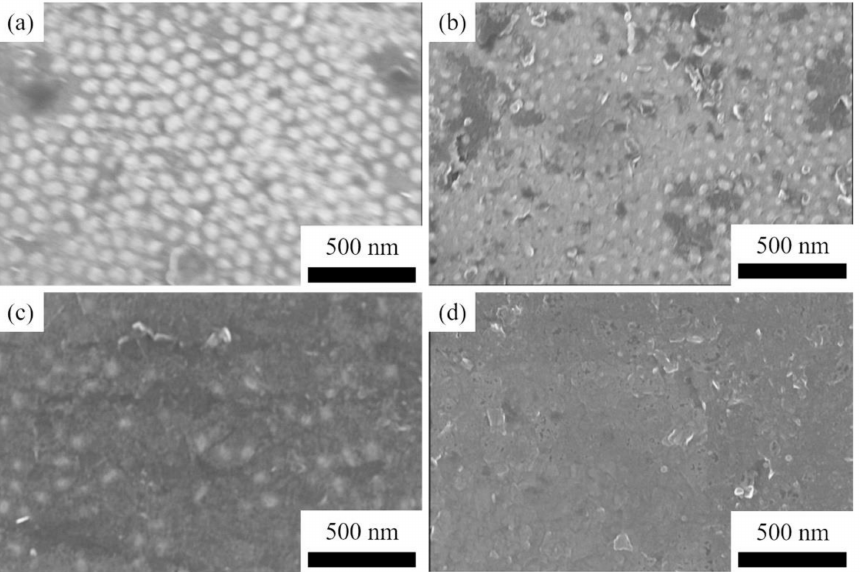
Figure 4. The microstructure of SiC nanoarrays after soaking time of 5 min at the temperature of the raw material from 2100 ◦ C to 2250 ◦ C: ( a ) 2100 ◦ C; ( b ) 2150 ◦ C; ( c ) 2200 ◦ C; ( d ) 2250 ◦